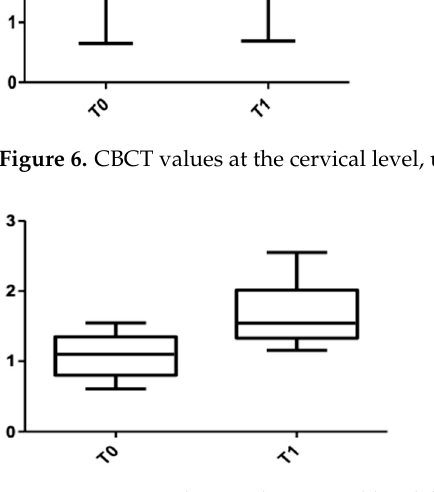
Figure 6. CBCT values at the cervical level, upper arch, at T0 and T1 for males.